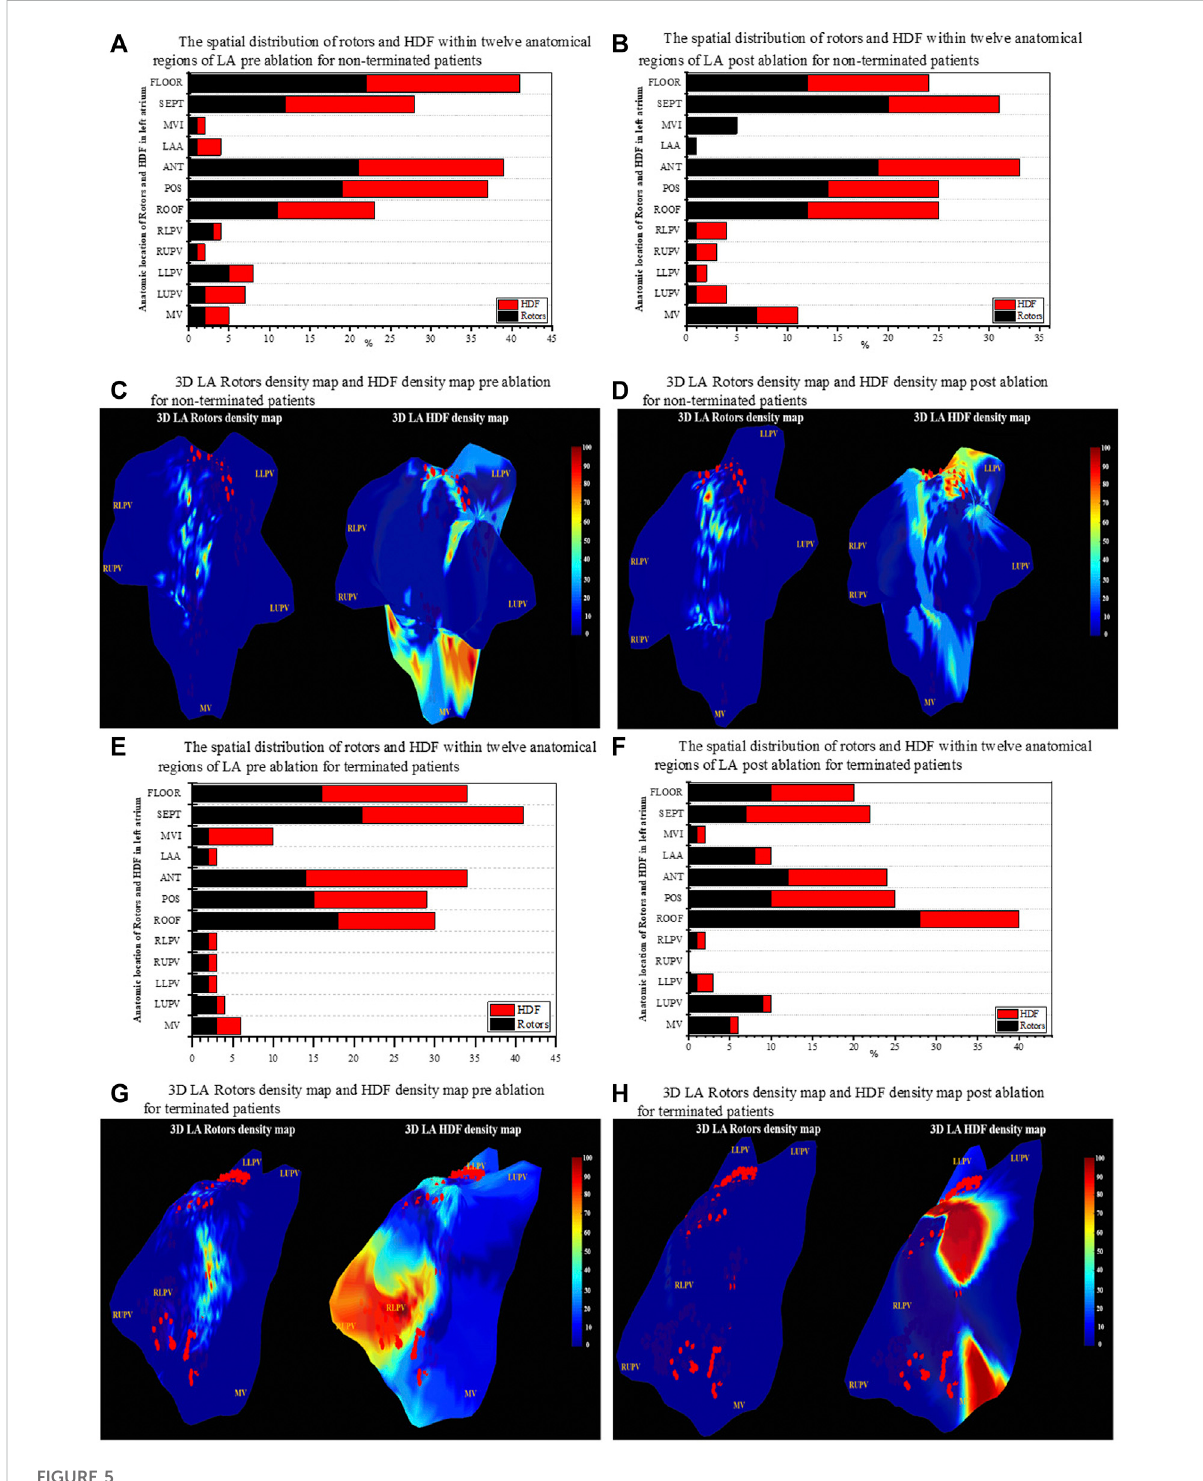
FIGURE 5 Regional distribution of rotors and HDF across the LA region. (A) Spatial distribution of HDF and rotors for 12 anatomical regions in LA for non- terminated patient pre-ablation. (B) Spatial distribution of HDF and rotors for 12 anatomical regions in LA for non-terminated patients post-ablation. (C) 3D LA geometry of rotors density and map HDF density map for non-terminated patient pre ablation. (D) 3D LA geometry of rotors density map andHDFdensitymapfornon-terminatedpatientspost-ablation. (E) SpatialdistributionofHDFandrotorsfor12anatomicalregionsintheLAfor terminated patients pre ablation. (F) Spatial distribution of HDF and rotors for 12 anatomical regions in the LA for terminated patients post-ablation. (G) 3D LA geometry of rotors density map and HDF density map for terminated patients pre-ablation. (H) 3D LA geometry of rotors and density